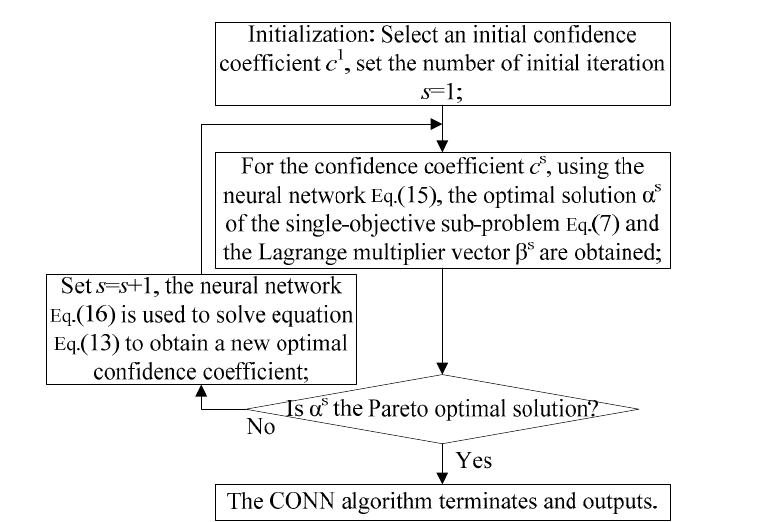
Figure 1. The flow diagram of the collaborative neural network (CONN) algorithm.